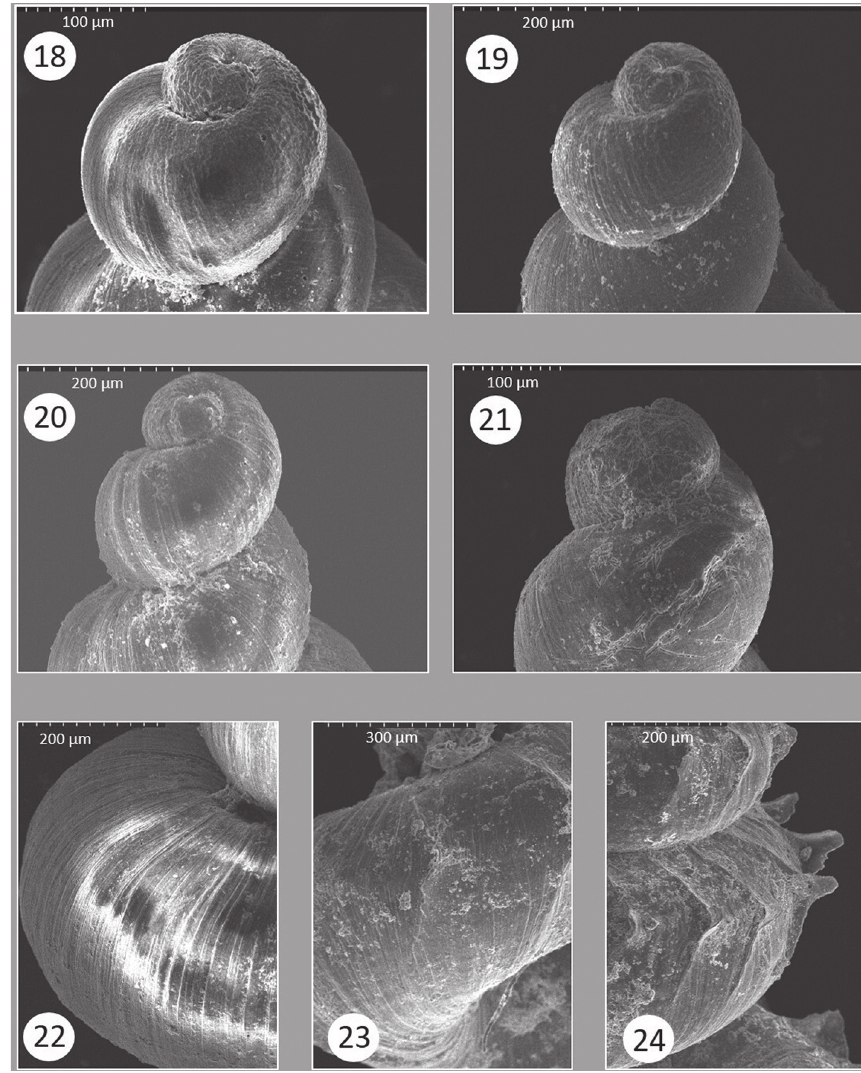
The general turriform shell shape of Phreatoviesca spinosa is common among other stygo- biotic cochliopids that occupy hyporheic and phreatic habitats in the Edwards